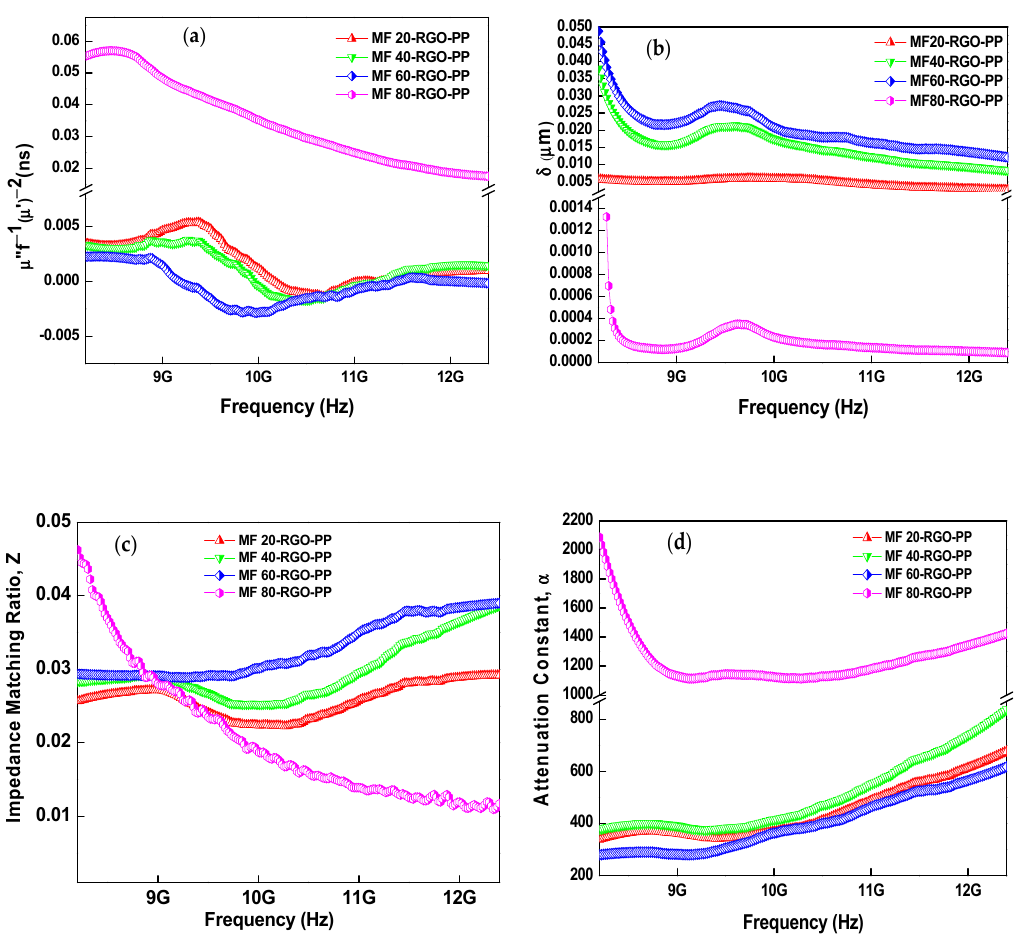
Figure 15. Frequency-dependent ( a ) eddy current loss, ( b ) skin depth, ( c ) impedance matching ratio and ( d ) attenuation constant of prepared MF20-RGO-PP, MF40-RGO-PP, MF60-RGO-PP and MF80-RGO-PP composite samples.